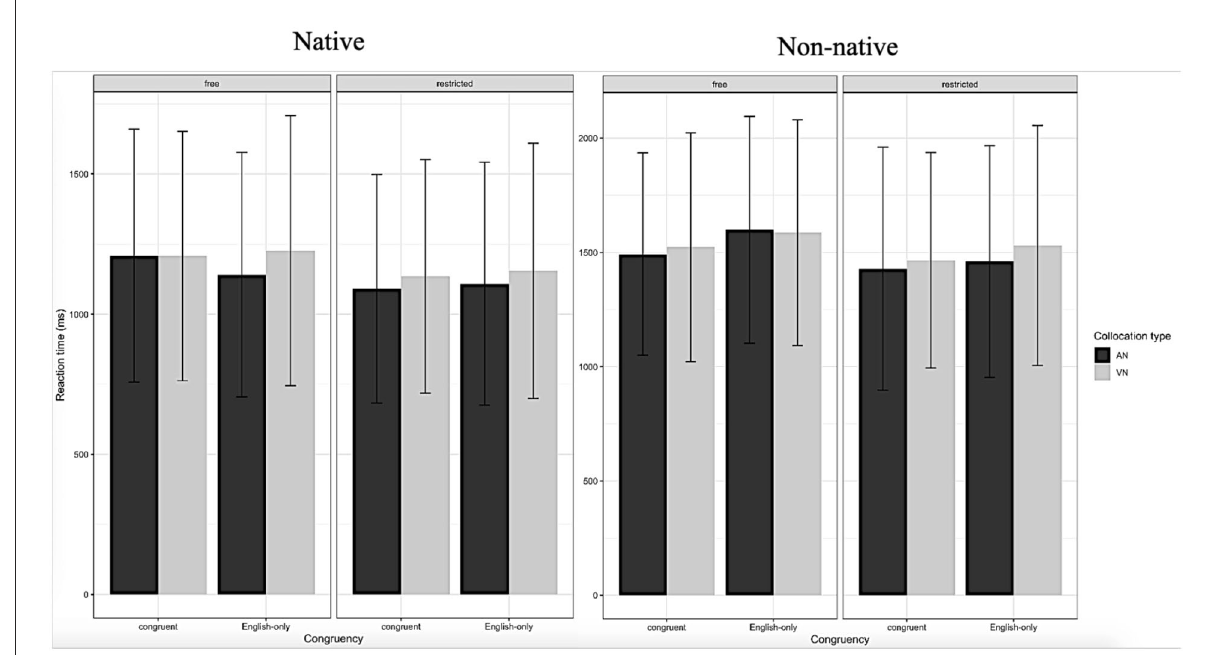
FIGURE1 Mean response time for different conditions of NSs and NNSs.